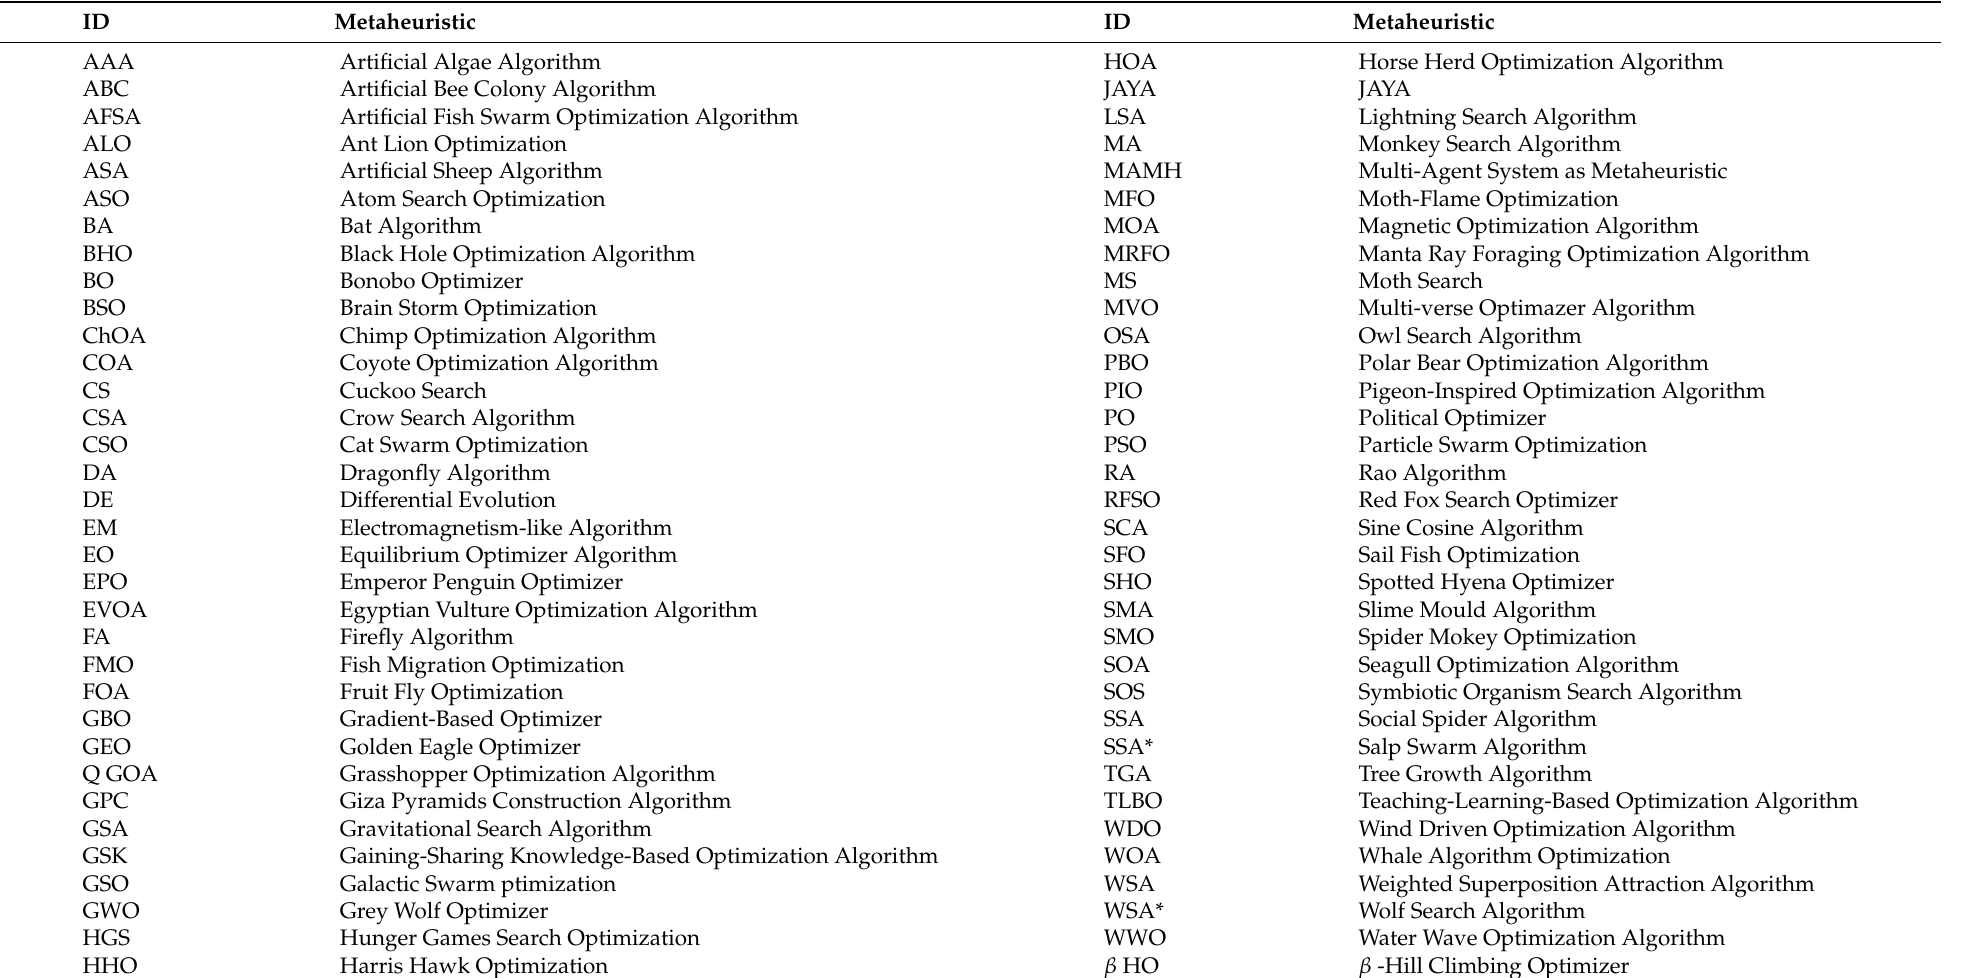
Table 4. Acronyms of the investigated